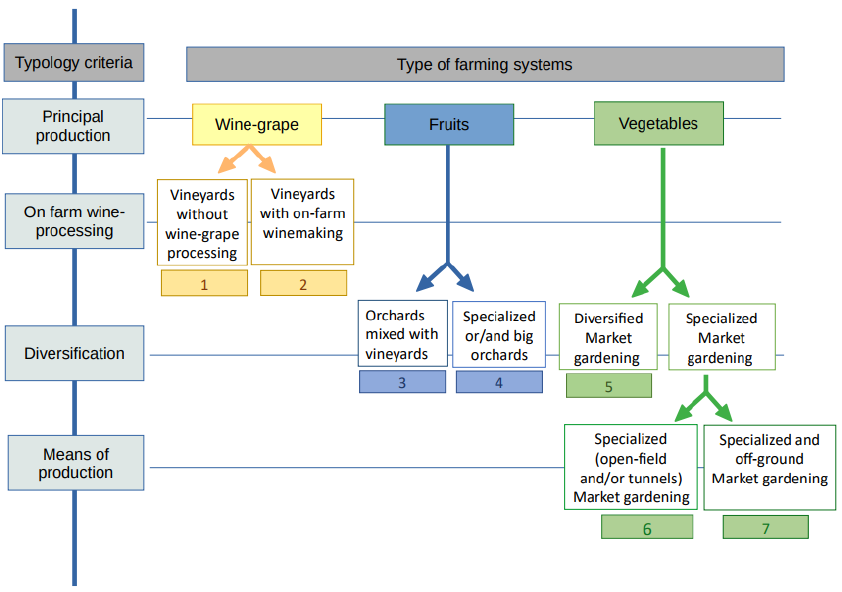
Figure 6. Farming system typology at local scale.